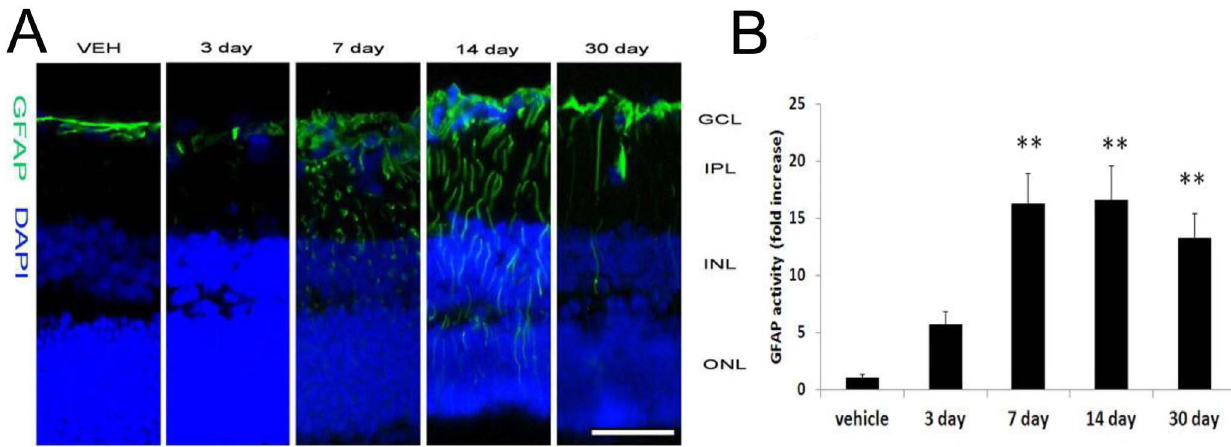
Figure 2. Effects of apelin protein on Mu¨ller cells in normal rats. Immunofluorescence evaluation of GFAP distribution in the retinas of rats after intravitreal injection of apelin is shown (A). Densitometric quantification of GFAP activity is shown (B). GFAP were detected using fluorochrome- conjugated secondary antibodies. Nuclei were detected using DAPI. Merged images contain two color channels representing GFAP (green) and DAPI (blue). GCL, ganglion cell layer; IPL, inner plexiform layer; INL, inner nuclear layer; ONL, outer nuclear layer; VEH, vehicle. ** indicates p , 0.01 vs. vehicle. Scale bars: 50 m m.